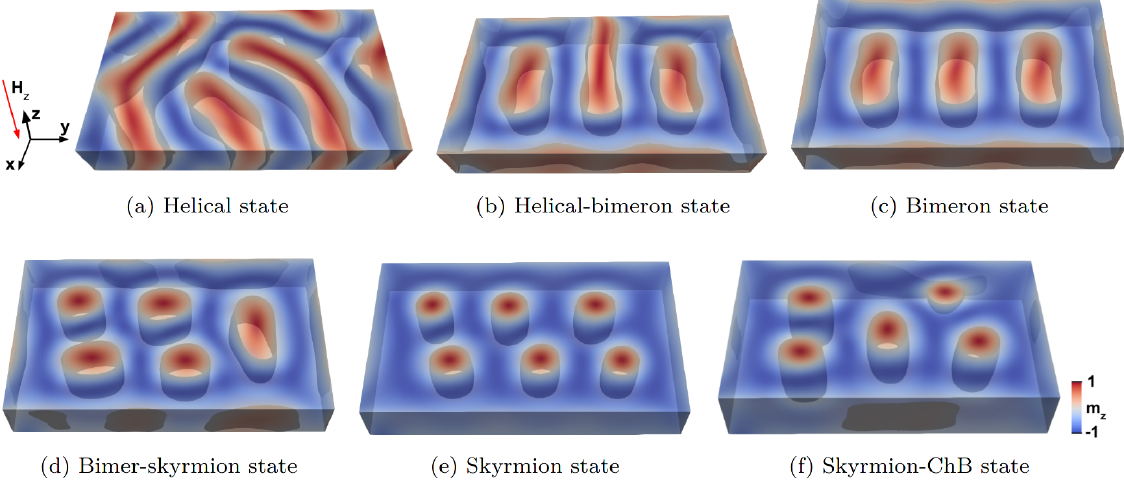
Figure 1. Non-trivial magnetization states forming in a rectangular FeGe platelet (310nm × 180nm) of varying thickness (between 5nm and 60nm) at different external field values. The color code describes the out-of-plane component m z of the normalized magnetization, and the isosurfaces indicate the regions where m z is equal to zero. Structures of this type appear at different film thicknesses as the external magnetic field is applied along the negative z direction and is varied between 0mT and 900mT. The arrangement of these configurations in the image corresponds, roughly, to the order in which the preferential configurations appear upon increasing the field